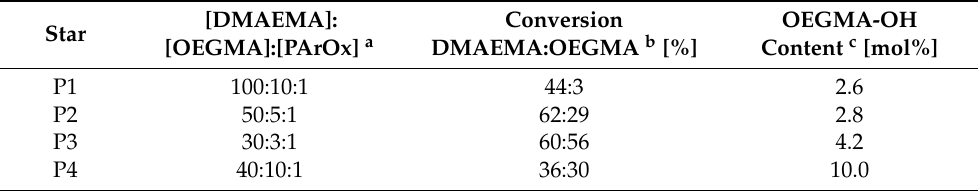
Table 1. Polymerization conditions for poly( N , N -dimethylaminoethyl methacrylate (DMAEMA)- co- hydroxyl-bearing oligo(ethylene glycol) methacrylate (OEGMA-OH))